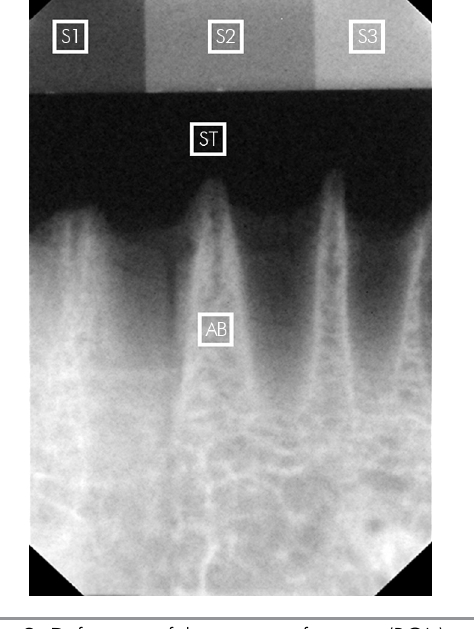
Figure 2. Definitions of the regions of interest